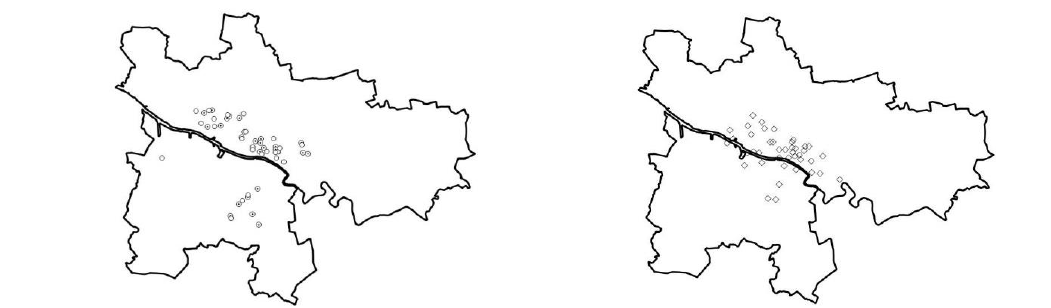
Figure 2. Location of car share (left) and bicycle share (right) schemes in Glasgow.